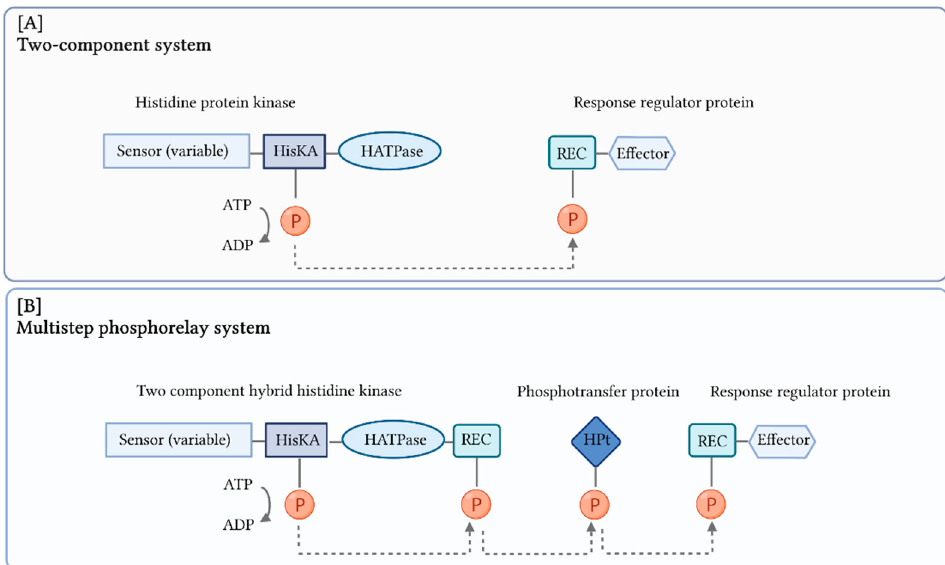
Figure 6. Schematic representation of the prokaryotic two-component system (TCS) and the eukaryotic multistep phosphorelay system (MSP). ( A ) For the two-component system, the phosphate transport is shown from the histidine kinase phosphoacceptor domain (HisKA) of the histidine protein kinase to the signal receiver domain (REC) of the response regulator protein. ( B ) The MSP system includes additional regulatory steps: the phosphate is transferred from the HisKA of the two-component hybrid histidine kinase to a REC domain within the same protein and is subsequently transferred via a phosphotransfer protein to the response regulator protein. The phosphate transfer is indicated by arrows.